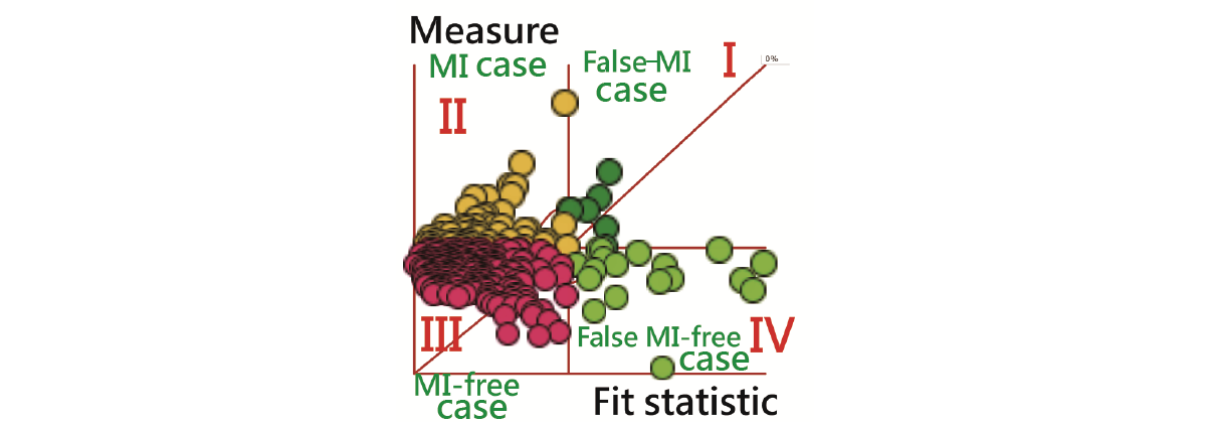
Figure 4. Four classes separated by 2 variables using the Rasch analysis. MI: mental